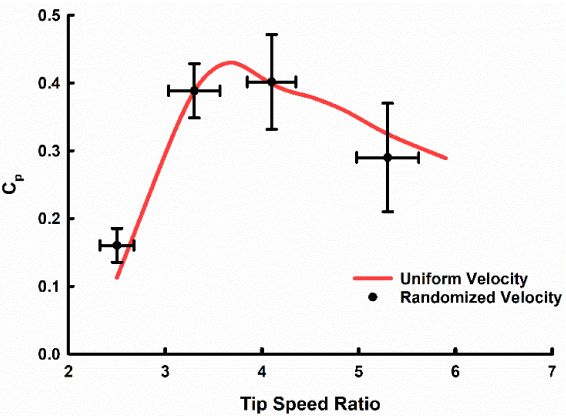
Figure 12. Effect of tip speed ratio on Coefficient of Performance (C p ) with random wind